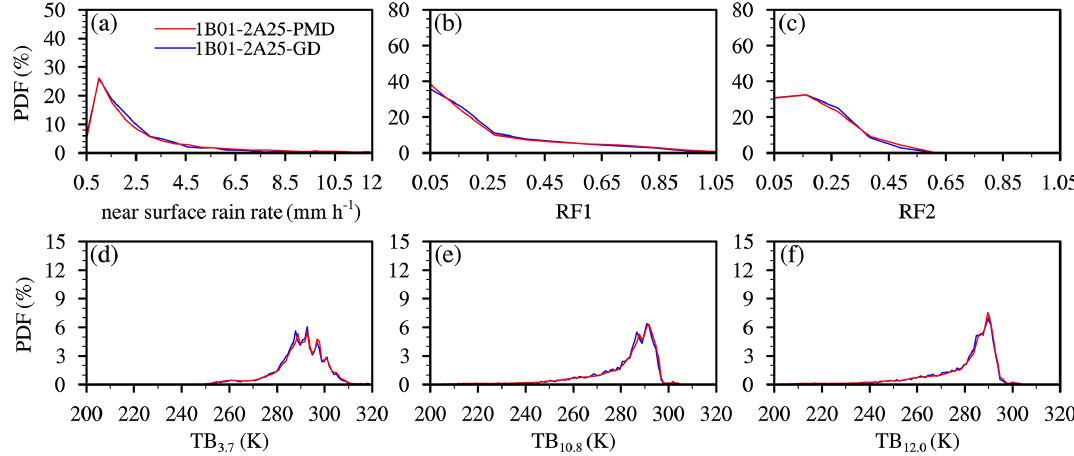
Figure 3. PDFs of (a) the near-surface rain rate, (b) RF1, (c) RF2, (d) TB 3 . 7 , (e) TB 10 . 8 and (f) TB 12 . 0 in 1B01-2A25-PMD (red line) and 1B01-2A25-GD (blue line) for orbit number 37362 on 5 June 2004.